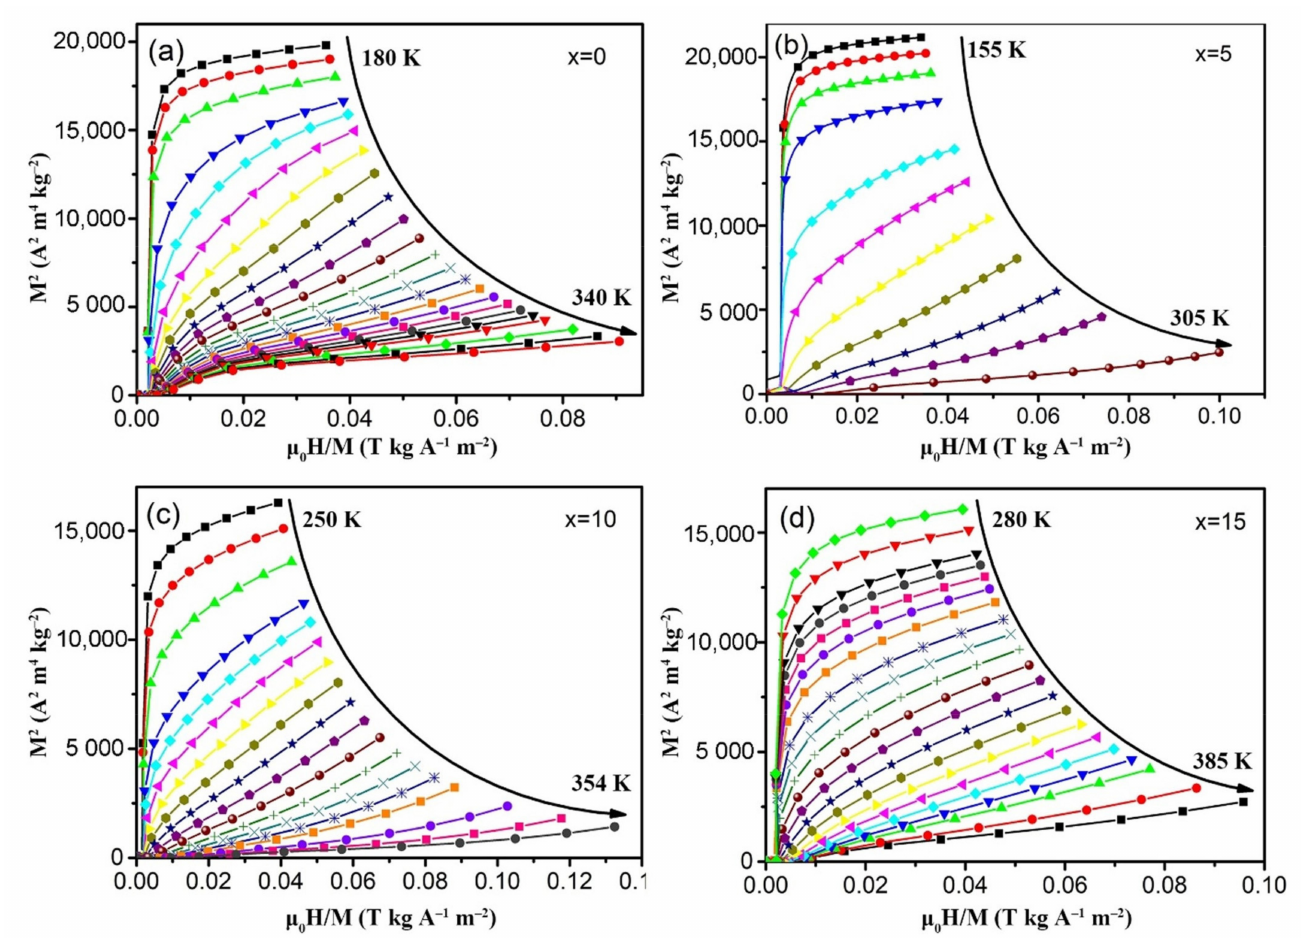
Figure 7. Arrott plots ( a – d ) of the LaFe 11.6 Si 1.4 / x wt.%Ce 2 Co 7 ( x = 0, 5, 10, and 15) composites sintered at 1373 K for 6 h.